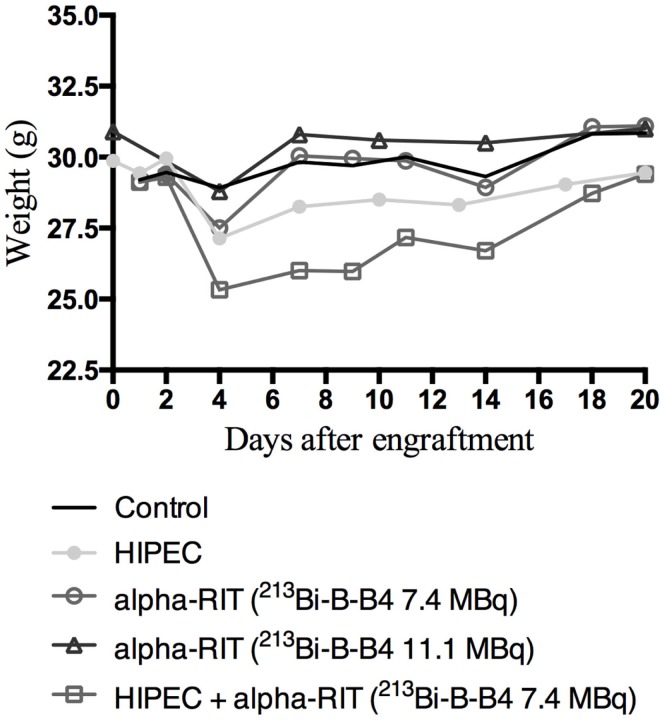
Weight monitoring of mice after treatment. This figure illustrates the weight changes for each group (control n = 6, HIPEC n = 5, alpha-RIT 7.4 MBq n = 6, alpha-RIT 11.1 MBq n = 7, and HIPEC + alpha-RIT 7.4 MBq n = 5) according to the day after engraftment.